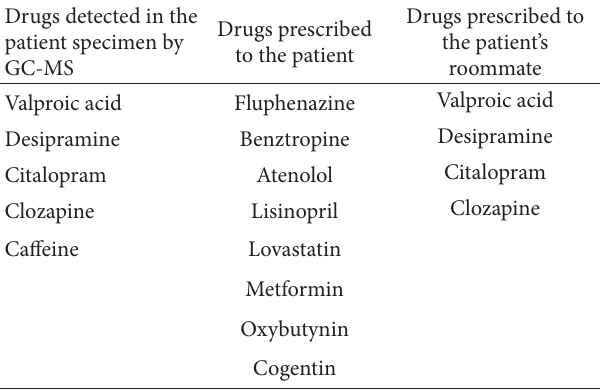
Table 3: List of drugs detected in the patient specimen, list of drugs prescribed to the patient and the list of drugs prescribed to the patient’s roommate. From this comparison it was clear that the patient was administered the drugs of her roommate which potentially caused the altered mental status for the